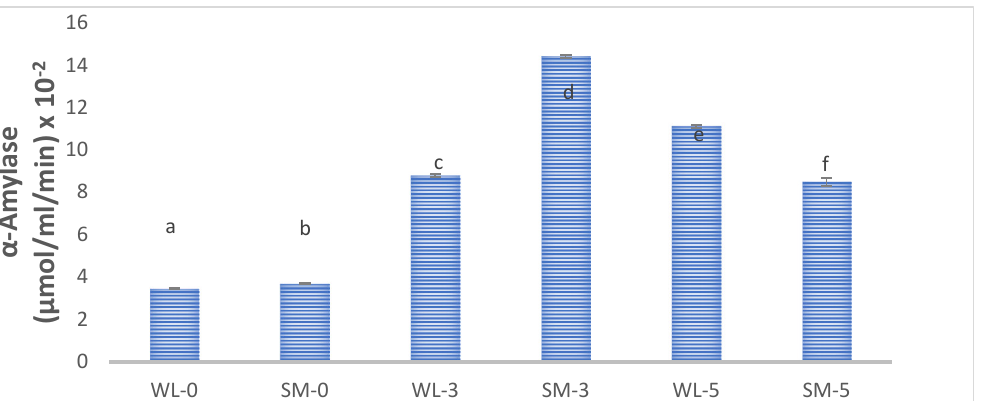
Figure 1. Lactate dehydrogenase activity of fermented leaves of S. monostachyus . Results = mean ± sd ( n = 3). Keys: SM = S. monostachyus ; WL = water leaf ( T. fruticosum ).